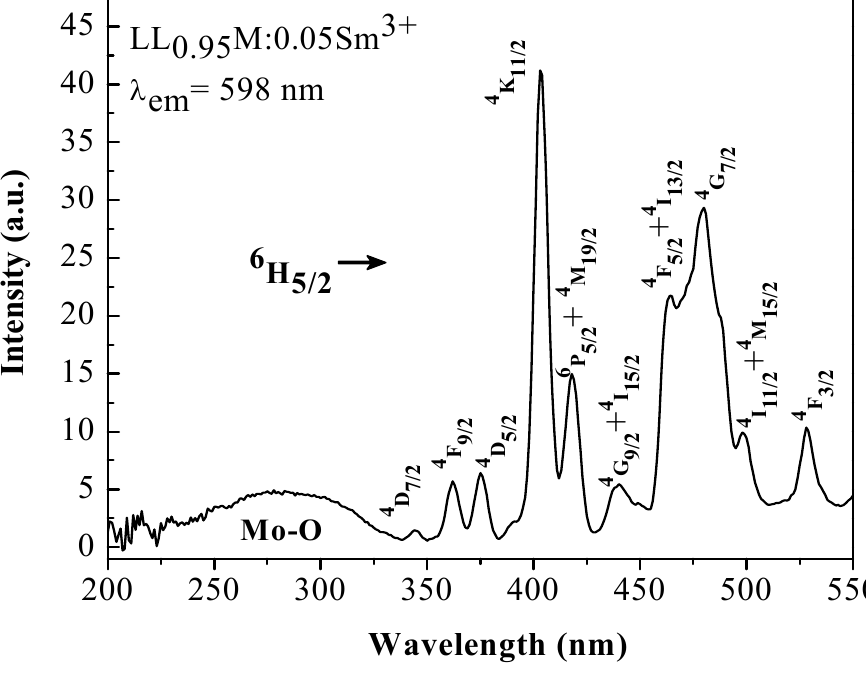
Figure 2. Excitation spectrum of LL 0.95 M:0.05Sm 3+ phosphor, monitoring the emission at 598 nm.